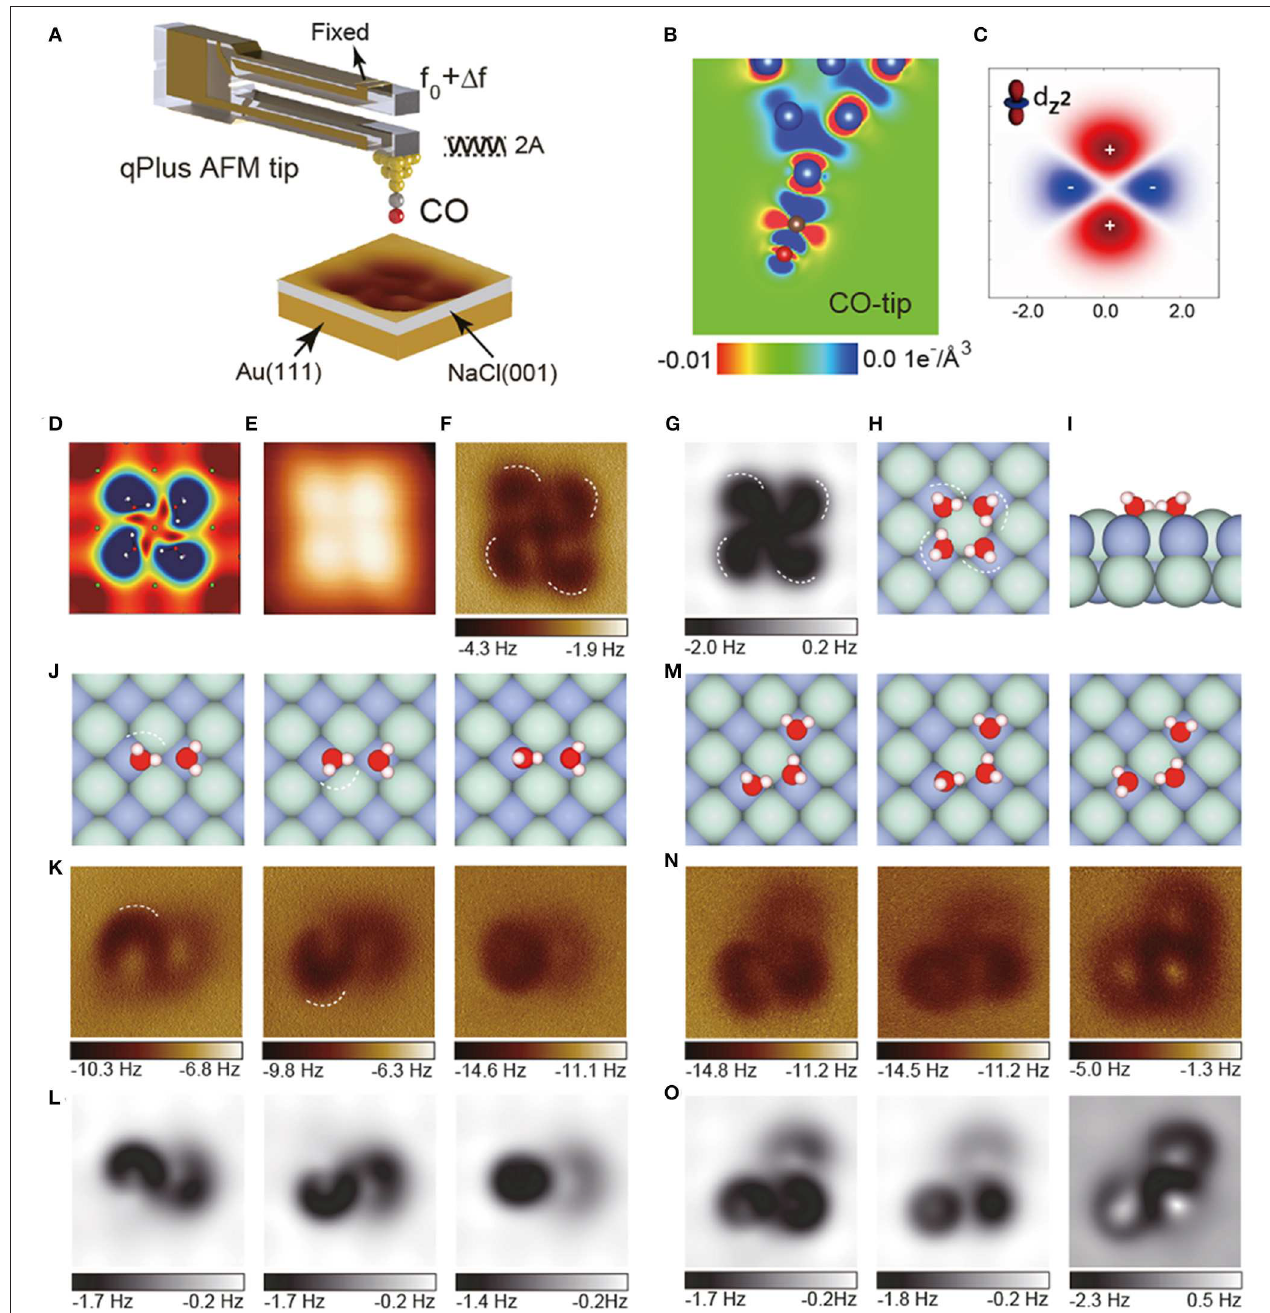
FIGURE 1 | AFM images of water clusters with a CO-terminated tip. (A) Schematic of a qPlus-based nc-AFM with a CO-tip. The cantilever oscillates at an amplitude of A and the tip-sample force-induced frequency shift of the cantilever from its natural resonance frequency (f 0 ) is 1 f. (B) Charge distribution of the CO-tip from DFT calculations. (C) xz-cut of the charge distribution of quadrupole ( d z 2 ) tip model. (D) Calculated electrostatic potential map of the water tetramers in a plane 60 pm above the outermost H atom. (E) Constant-current STM images acquired at (100mV, 20pA). (F) Experimental 1 f images recorded at the tip heights of 100 pm. The tip height is referenced to the STM set point on the NaCl surface (100mV, 50pA). (G) Simulated AFM images of water tetramer. (H,I) Top and side view of the water tetramer adsorbed on the NaCl(001) surface, respectively. (J–L) Geometric structures, experimental and simulated 1 f images of weakly bonded water dimers, respectively. The crooked depressions in the AFM images are highlighted by dashed lines in (K) . (M–O) Geometric structures, experimental and simulated 1 f images of weakly bonded water trimers, respectively. H, O, Cl, and Na atoms in the atomic models are denoted as white, red, cyan, and purple spheres, respectively. The oscillation amplitude is 100 pm. All the simulations were done with a quadrupole ( d z 2 ) tip ( k = 0.5N m − 1 , Q = − 0.2 e). The size of the images is 1.2 × 1.2nm. Adapted with permission from Peng et al. (2018b).